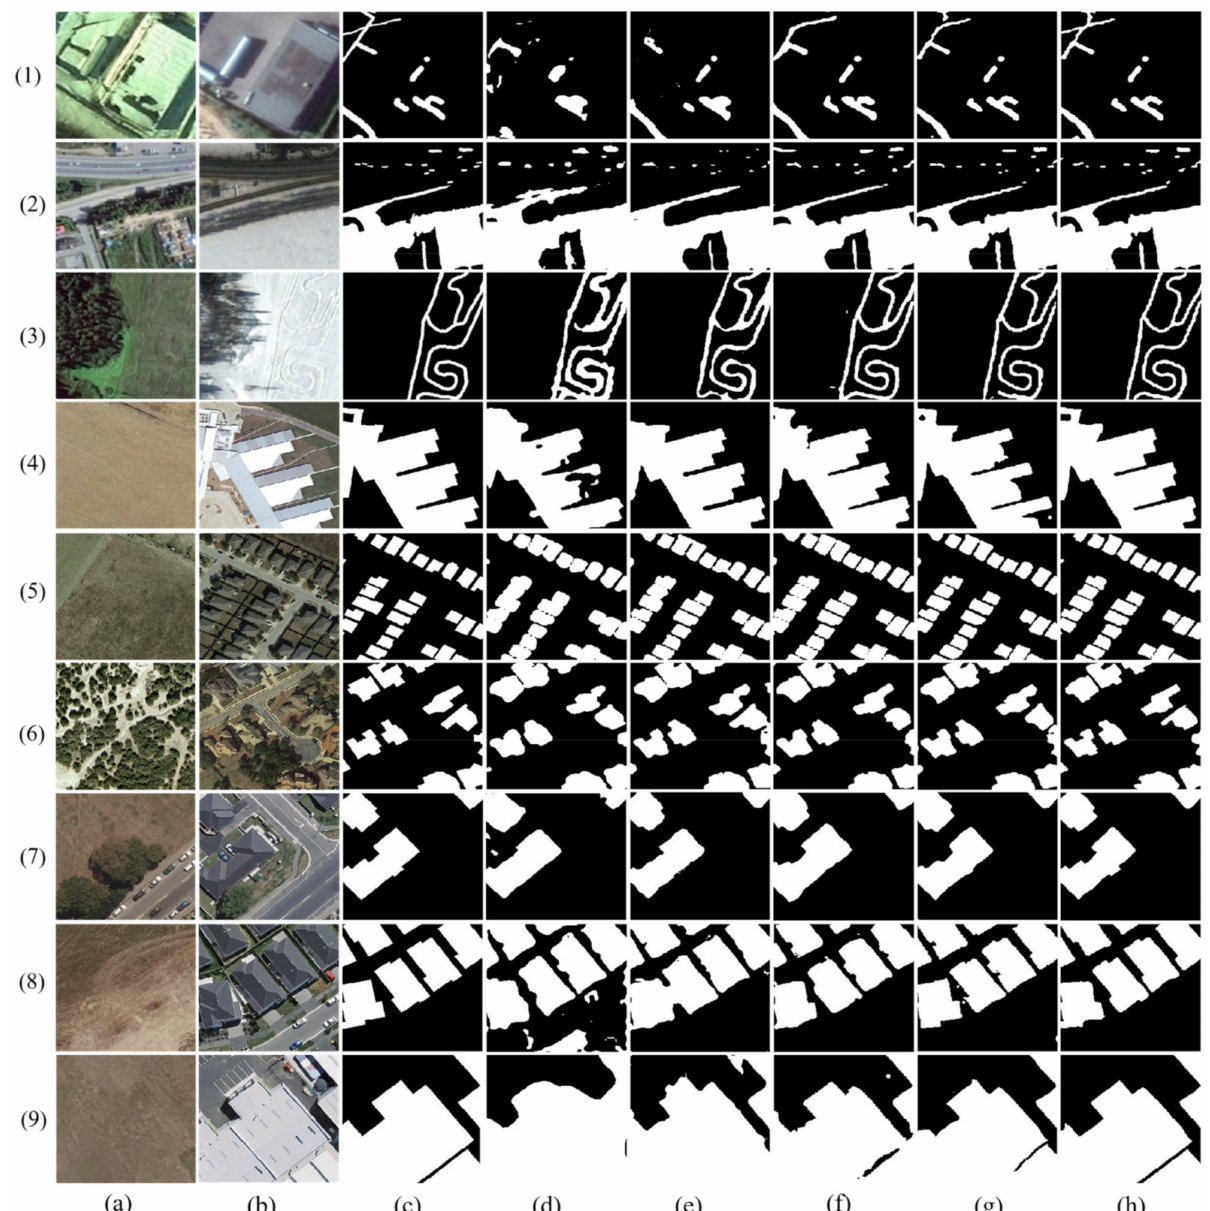
Figure 11. Visualization comparison plots of each network on different datasets in the ablation experiment. ( 1 – 3 ) indicate samples from the CDD dataset, ( 4 – 6 ) indicate samples from the LEVIR-CD dataset, and ( 7 – 9 ) indicate samples from the WHU-CD dataset. ( a ) Image T1. ( b ) Image T2. ( c ) Ground truth. ( d ) Baseline. ( e ) Baseline+FEM. ( f ) Baseline+FEM+FFM_S1. ( g )